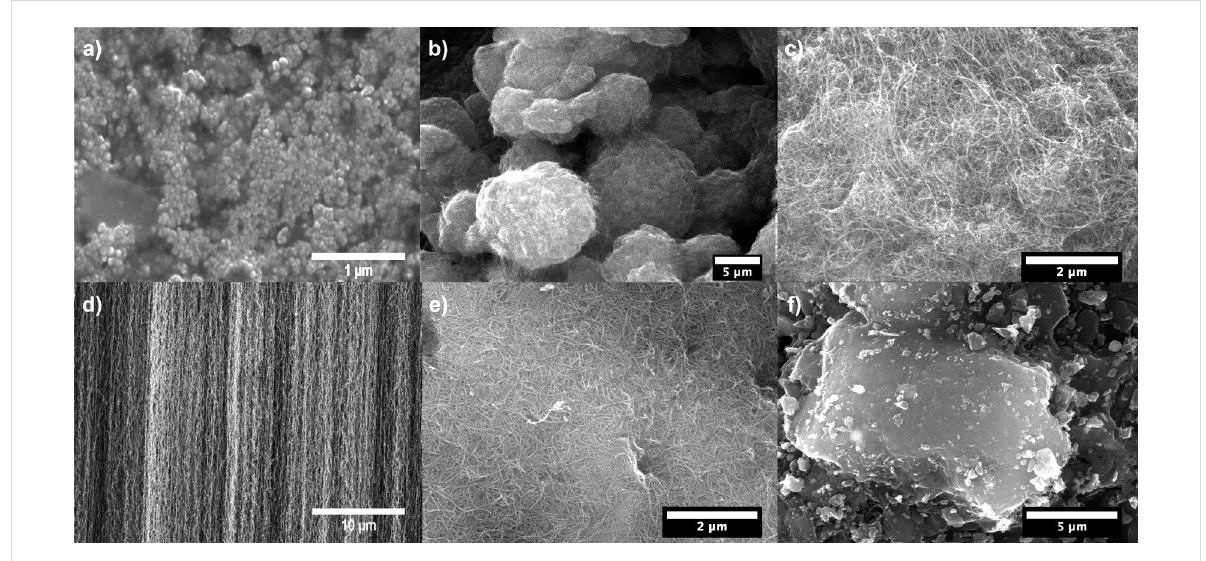
Figure 2: SEM image of the carbon samples used in the study: a) CNHs, b) MWNTs, c) high-magnification image of MWNTs revealing their unordered, felt-like structure, d) VACNTs revealing their alignment, e) unordered SWNTs, f) Norit R1 Extra.